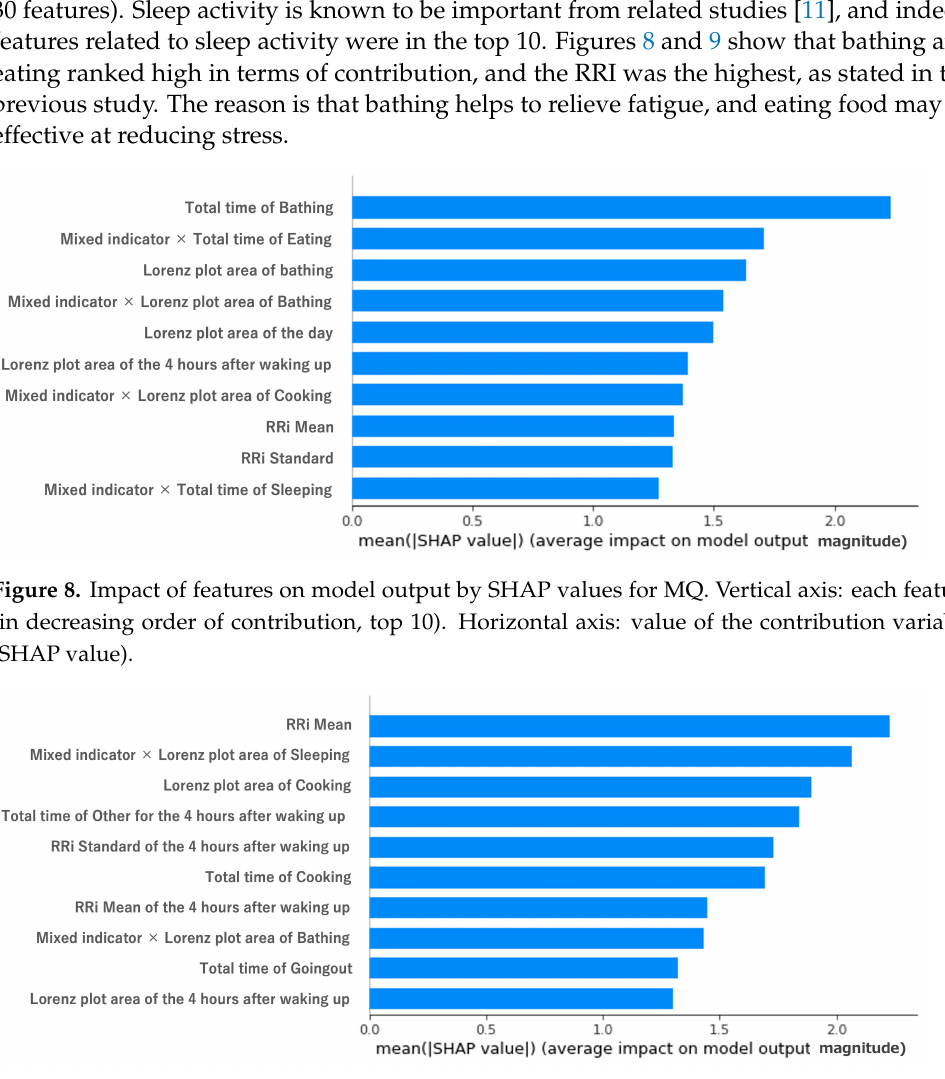
Figure 9. Impact of features on model output by SHAP values for NQ. Vertical axis: each feature (in decreasing order of contribution, top 10). Horizontal axis: value of the contribution variable (SHAP